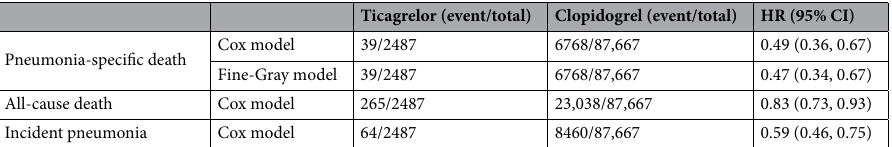
Table 2. The association between use of ticagrelor with pneumonia-specific death, all-cause death, and incident pneumonia in the overall cohort. Adjusted for age, gender, Charlson Comorbidity Index, number of outpatient visits during previous 12 months, number of hospitalizations during previous 12 months, year of first drug dispensing date, duration of drug use, baseline cerebrovascular diseases, diabetes and chronic obstructive pulmonary disease. Fine-Gray model is a survival model taking into account competing risk.